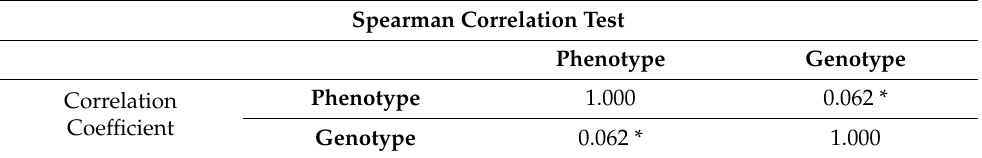
Table 3. Spearman’s correlation test. A weak positive correlation was observed between the genotypic and phenotypic data. Genotypic data: functional mutations (Positions 1812, 1880, and 1927) in the ALS gene. Phenotypic data: enzyme colorimetric